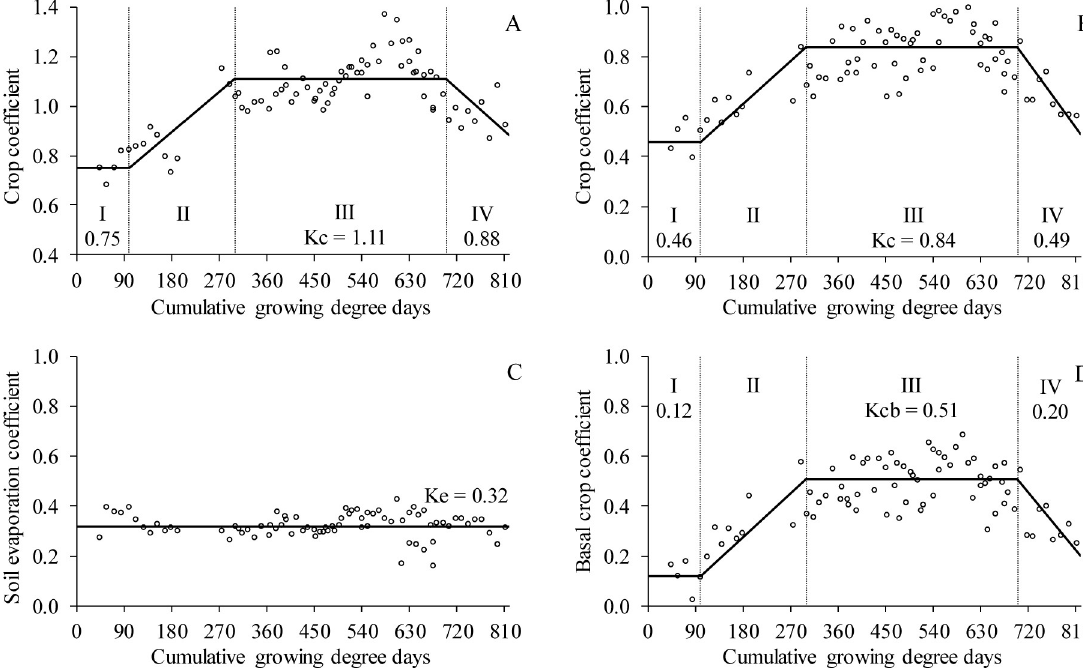
Fig 5. Crop coefficient (Kc) of Italian zucchini (A) cultivated without mulch and crop coefficient—Kc (B), evaporation coefficient—Ke (C) and basal crop coefficient—Kcb (D) of Italian zucchini cultivated with recycled paper as mulch. I, II, III, IV correspond to the development stages of the Italian zucchini. Vic¸osa-MG, DEA-UFV,